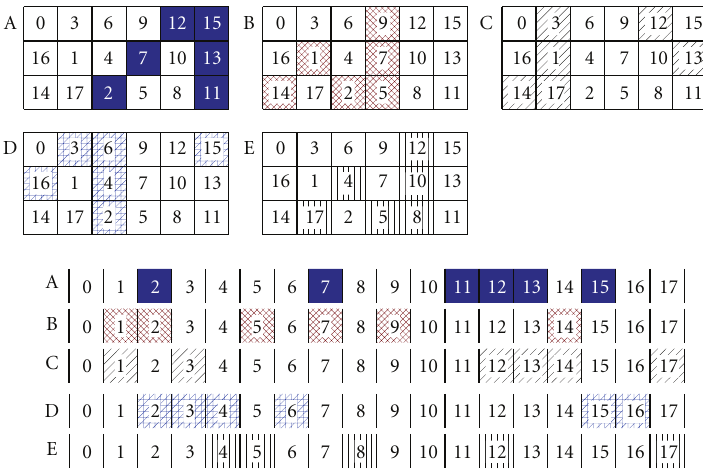
Figure 8: Cont-Diagonal element distribution and backward torus QS.